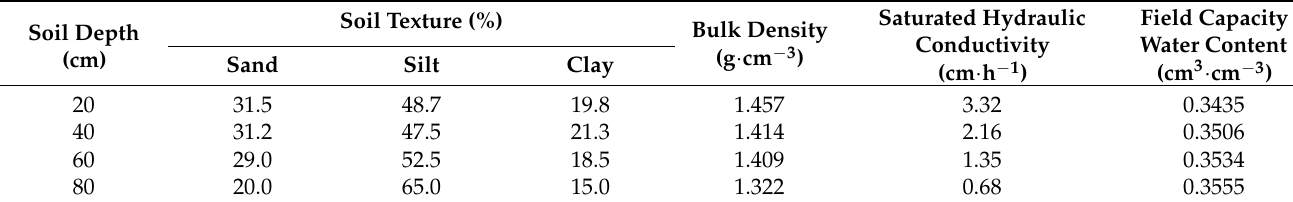
Table 1. Main physical parameters of different soil depth in the experimental